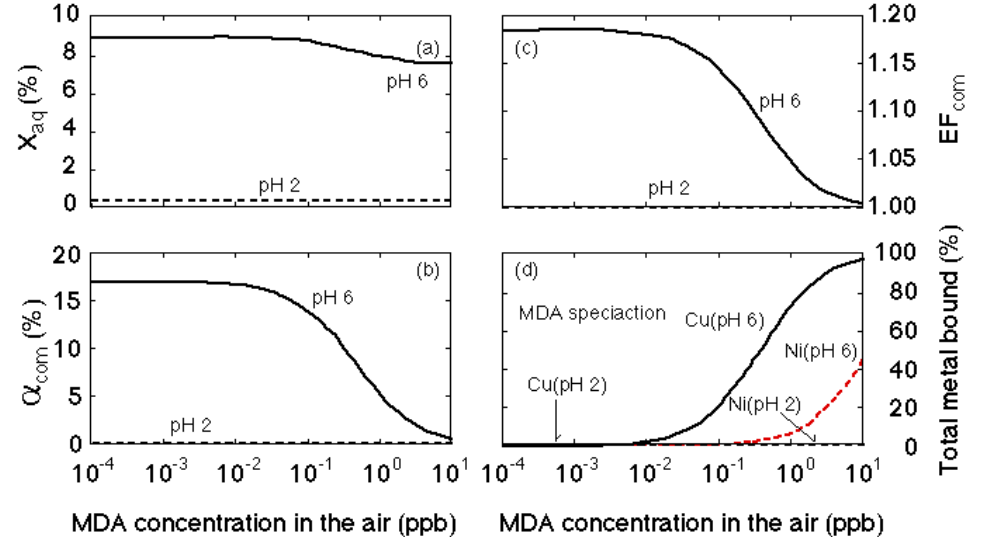
FIGURE 5 . The dissolution of MDA into fog water in the presence of copper(II) and nickel(II): (a) the partition of MDA between gas phase and fog water with pH 2 and 6; (b) the fraction of metal-MDA concentration to total MDA concentration in fog water with pH 2 and 6; (c) the enhanced uptake of MDA into fog water with pH 2 and 6; (d) speciation of the metals in fog water with pH 2 and 6. The calculation is made at LWC 10 –8 , [Cu] T = 22.0 µM and [Ni] T = 1.42